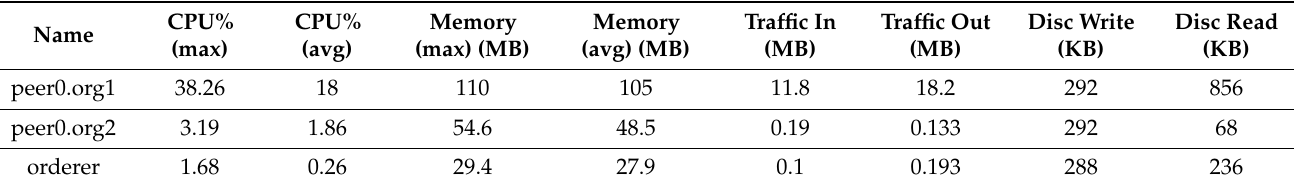
Table 5. System resource consumption.